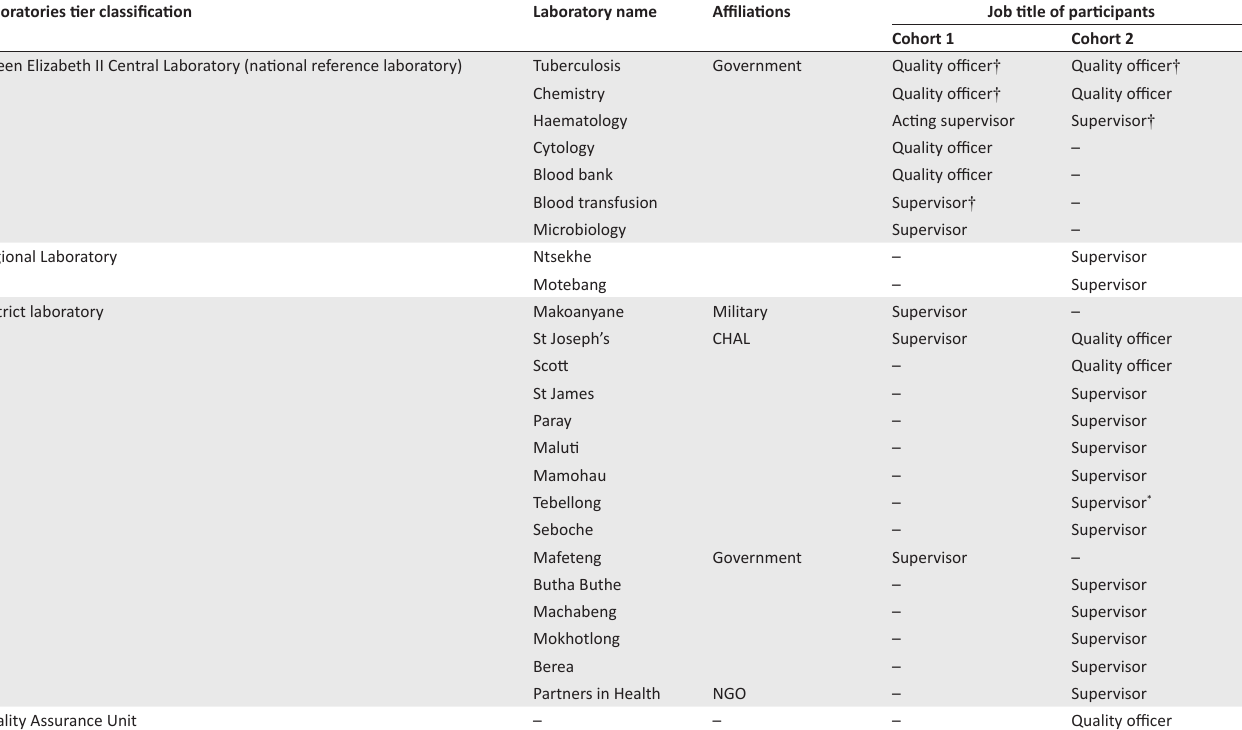
TABLE 1: Profile of Cohort 1 and Cohort 2 participants in the Strengthening Laboratory Management Towards Accreditation (SLMTA) programme in Lesotho. Laboratories tier classification